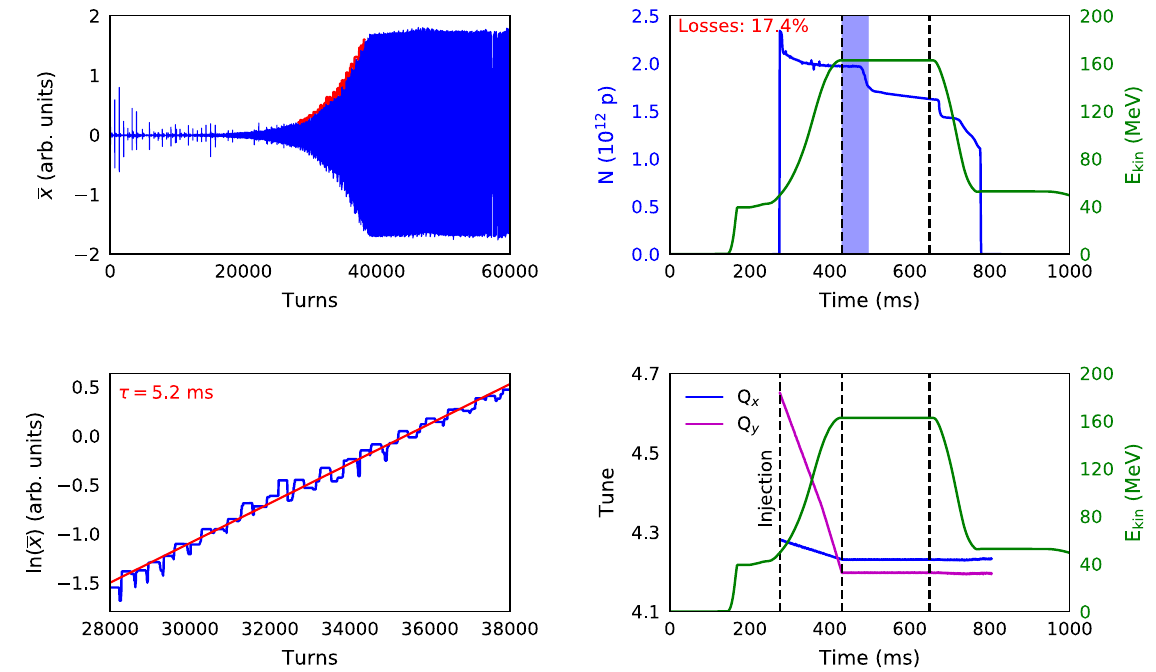
FIG. 2. Measurements with intensity N of 2 × 10 12 p at the beginning of the constant 160 MeV energy plateau, with Q x ¼ 4 . 23 and Q ¼ 4 . 20 . Top left: Horizontal centroid versus the number of turns. The range used to fit the rise time is marked in red. Bottom left: The y logarithm of the centroid ’ s positive envelope as a function of the number of turns. The rise time of the instability is 5.2 ms. Top right: Bunch intensity versus PSB cycle time. Losses are observed due to the instability at 160 MeVat ∼ 480 ms. Bottom right: Horizontal and vertical tunes as a function of the machine cycle time. The kinetic energy is also superimposed in green in the right-hand plots.